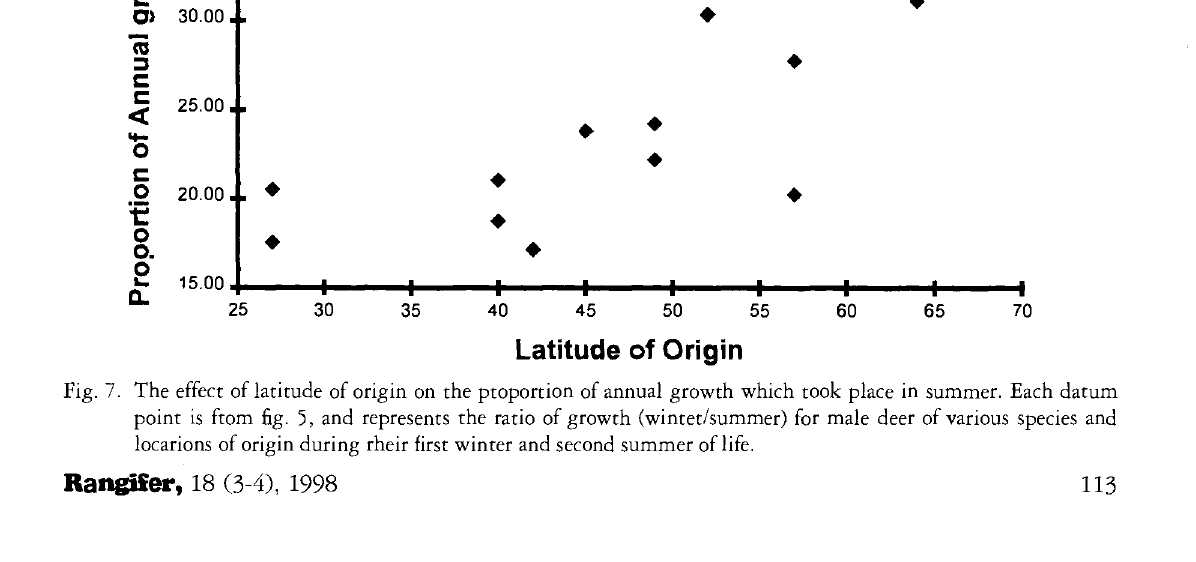
Fig. 7. The effect of latitude of origin on the ptoportion of annual growth which took place in summer. Each datum point is ftom fig. 5, and represents the ratio of growth (wintet/summer) for male deer of various species and locarions of origin during rheir first winter and second summer of